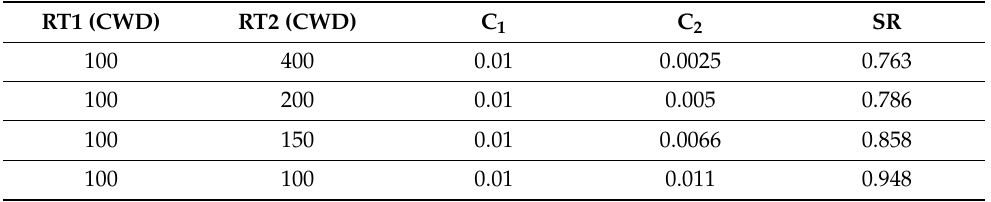
Table 1. SR calculation by applying Equation (11), (RT1: repair time for infrastructure 1, RT2: repair time for infrastructure 2, C1: coefficient for infrastructure 1, C2: coefficient for infrastructure 2, SR: seismic